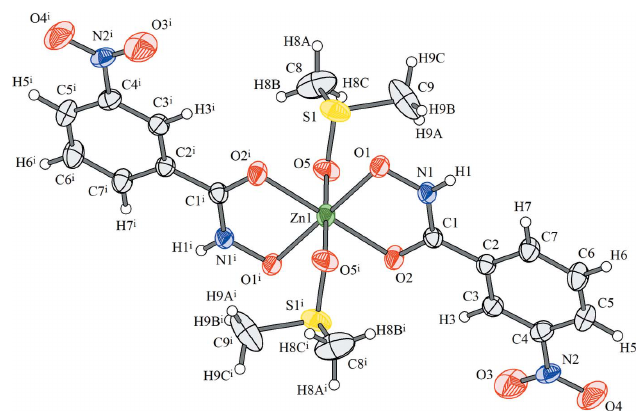
Figure 1 Molecular structure of [Zn(NBZH) 2 (DMSO) 2 ]. Ellipsoids are drawn at the 50% probability level [symmetry code: (i) (cid:4) x + 1, (cid:4) y + 1, (cid:4) z + 2].